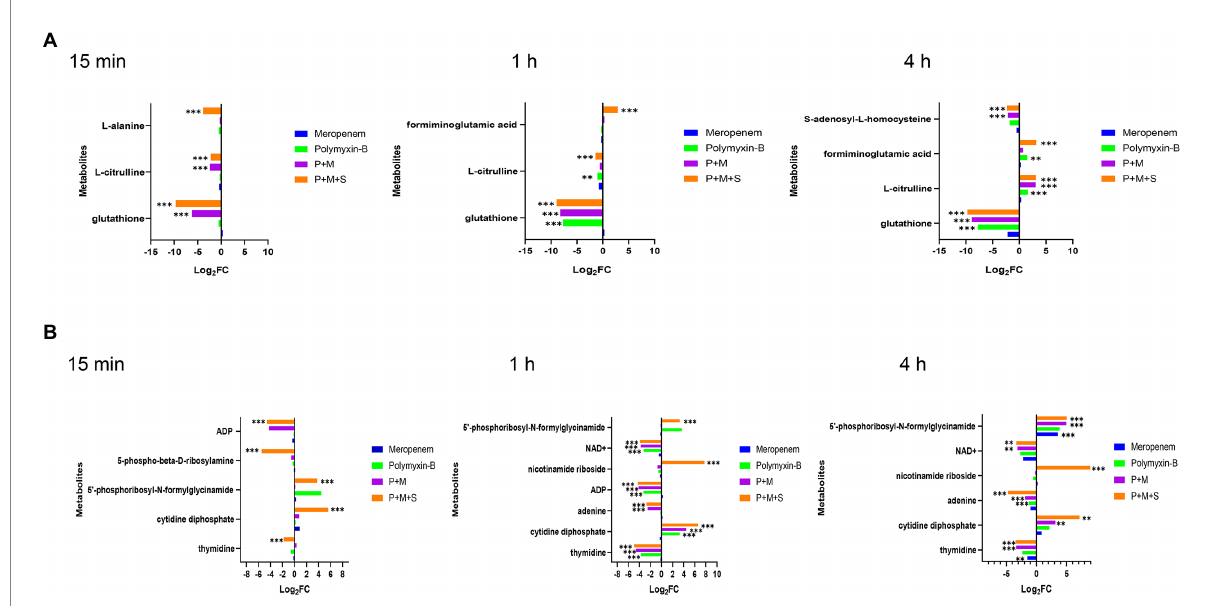
FIGURE 5 Perturbations of amino acid (A) and nucleotide (B) metabolism pathways in Acinetobacter baumannii treated with antibiotics as monotherapy and combination therapy at 15 min, 1 h and 4 h. Significantly perturbed metabolites were selected based on log 2 FC ≤ − 1 or ≥ 1, p < 0.05 and VIP > 1; * p < 0.05; ** p < 0.01; *** p <